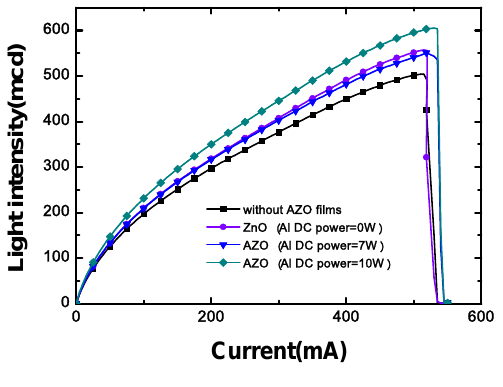
Figure 27. Light output power-current characteristics of LEDs with and without AZO films deposited under various Al dc power. Reprinted from Ref. [160] with